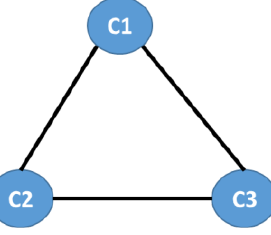
Figure 5. Structure of the Mortality Network. The nodes or vertices represent the causes of death: 𝐶 1 is the main cause, while 𝐶 2 and 𝐶 3 are the secondary causes. The edges or links represent the number of cooccurrences of both primary and secondary causes for every individual. Source: authors’ scheme.